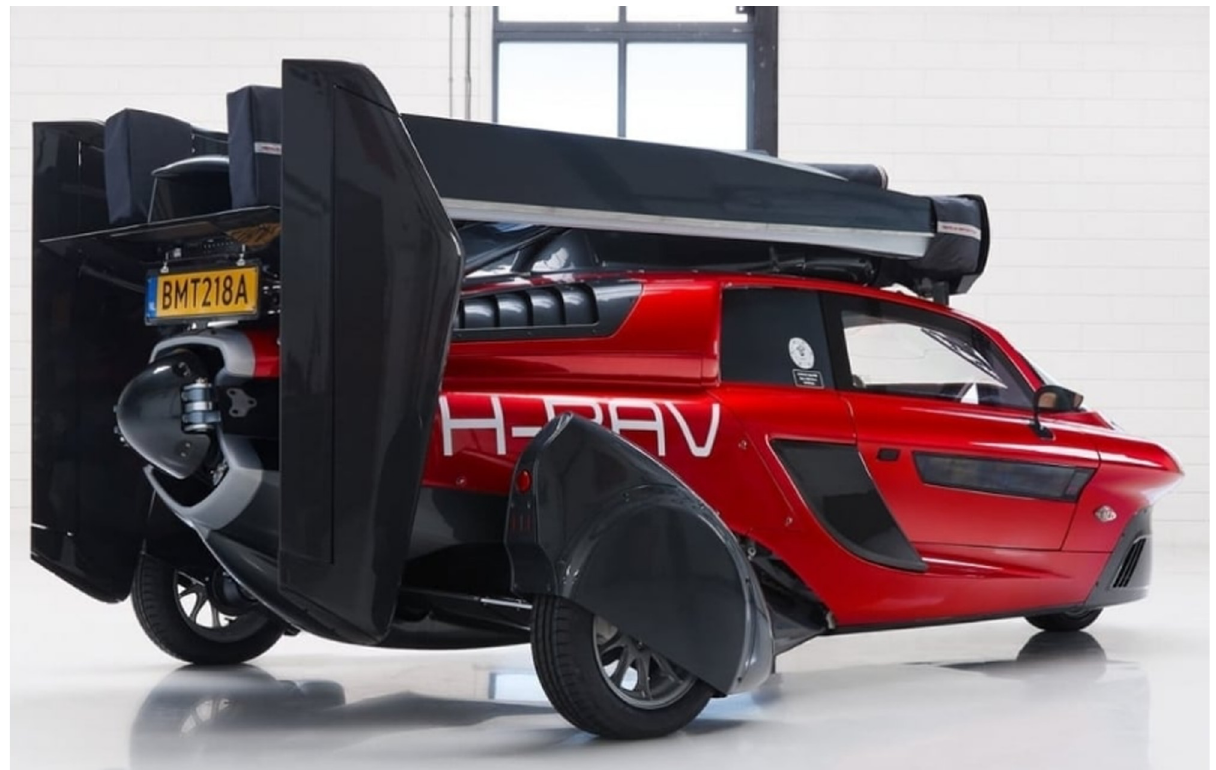
Figure 7: PAL - V Liberty Sport from outside with folded rotor and propeller ( image credit: PAL - V International B.V., used with permission )